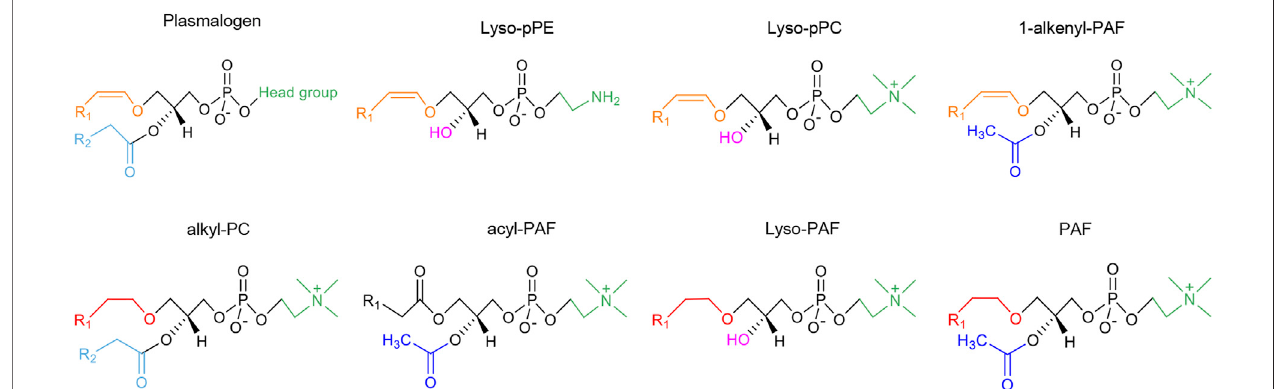
FIGURE 2 | The chemical structures of vinyl ether-bonded plasmalogen lipids as compared to the family of plasmalogen analogs and plasmalogenic analogs of PAF. The head group of plasmalogen at the sn-3 position ofglycerol backbone can be either ethanolamine or choline, designated as pPE or pPC, respectively.The lyso forms ofplasmalogen are labeled aslyso-pPEand lyso-pPC. Thechemicalstructuresofplasmalogens (pPE and pPC) and lyso-plasmalogens(lyso-pPE andlyso-pPC), PAF and its analogs (1-alkenyl-PAF, alkyl-PC, acyl-PAF and lyso-PAF) are all structurally related. The different colors represent the speci fi c chemical structure and functional group: alkyl groups (ether-bond) at sn-1 position are marked in red color; alkenyl groups (vinyl ether-bond) are marked in orange color; acyl groups (ester- bond) at sn-2position aremarked in blue (acyl groups are lightblue while acetyl groups are dark blue); the lyso form (hydroxyl-bond) are marked withpink color;and the head groups at sn-3 position are green. R 1 represents the alkyl chains. The saturated or unsaturated fatty acyl chains are labeled as R 2 , which is usually PUFA in plasmalogens and alkyl-PC, an acetyl group in PAF, acyl-PAF and 1-alkenyl-PAF, or a hydroxyl group in lyso-plasmalogens and lyso-PAF. The head groups of PAF and plasmalogenic analogs of PAF are often choline type, but can be ethanolamine type for pPE or lyso-pPE. In the upper row of the fi gure, the molecular structures are considered as plasmalogen analogs. In the lower row, the molecular structures are more similar to PAF, and therefore termed as plasmalogenic analogs of PAF.